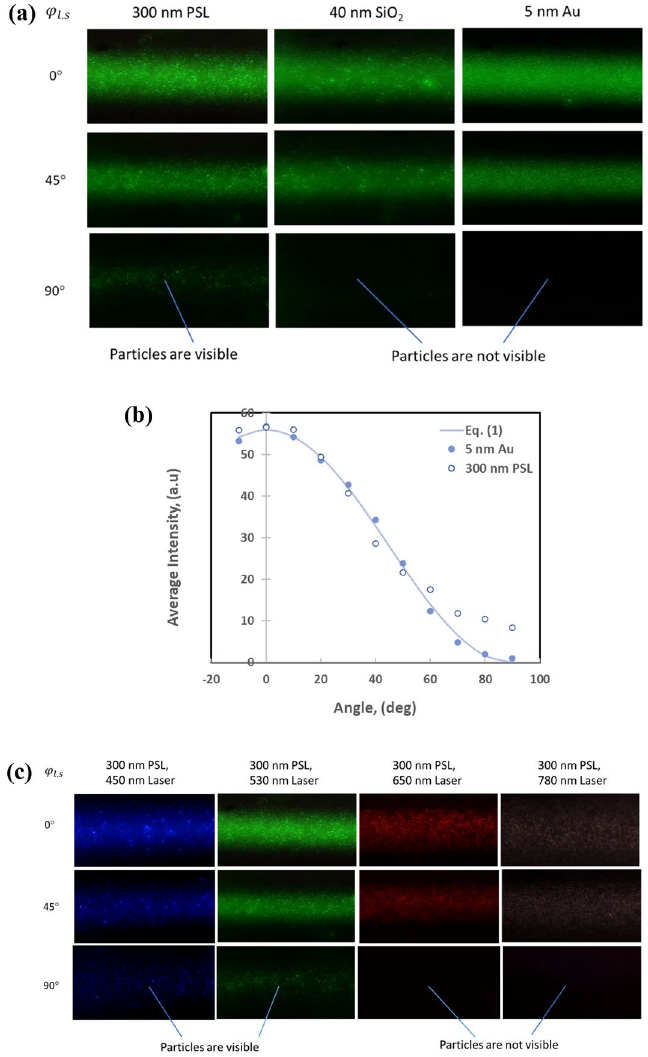
Figure 6. Effect of the incident light linear polarization on images of particle light scattering. ( a ) Images of the particles of different sizes when the angle ϕ l.s is 0 ◦ , 45 ◦ , and 90 ◦ . Note that when ϕ l.s 300 nm PSL particles are visible, and the 40 nm SiO 2 and 5 nm Au particles are not visible. ( b ) A plot of the average intensity extracted from particle light scattering image for 5 nm Au particles and 300 nm PSL particles when the angle ϕ l.s changes from - 10 ◦ to 90 ◦ . ( c ) Images of light scattering of 300 nm PSL particles when using lasers of different wavelengths. The polarization of the incident light is rotated at three different angles relative to the sensing plane of the sensor. Note that when the angle is perpendicular ϕ l.s particles are still visible when using blue and green lasers, but not visible when using red and infrared